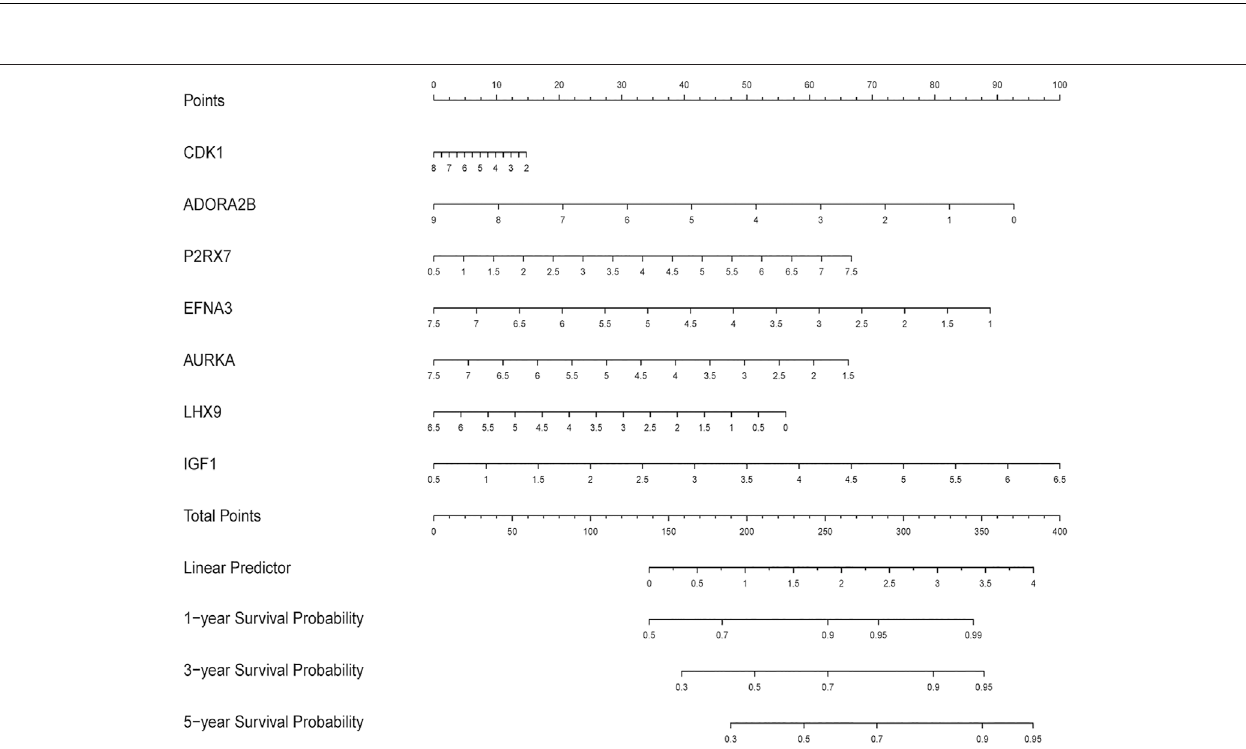
FIGURE 7 | The nomogram predicting the survival status of STS patients on the base of the expression level of 7 DEGRGs.